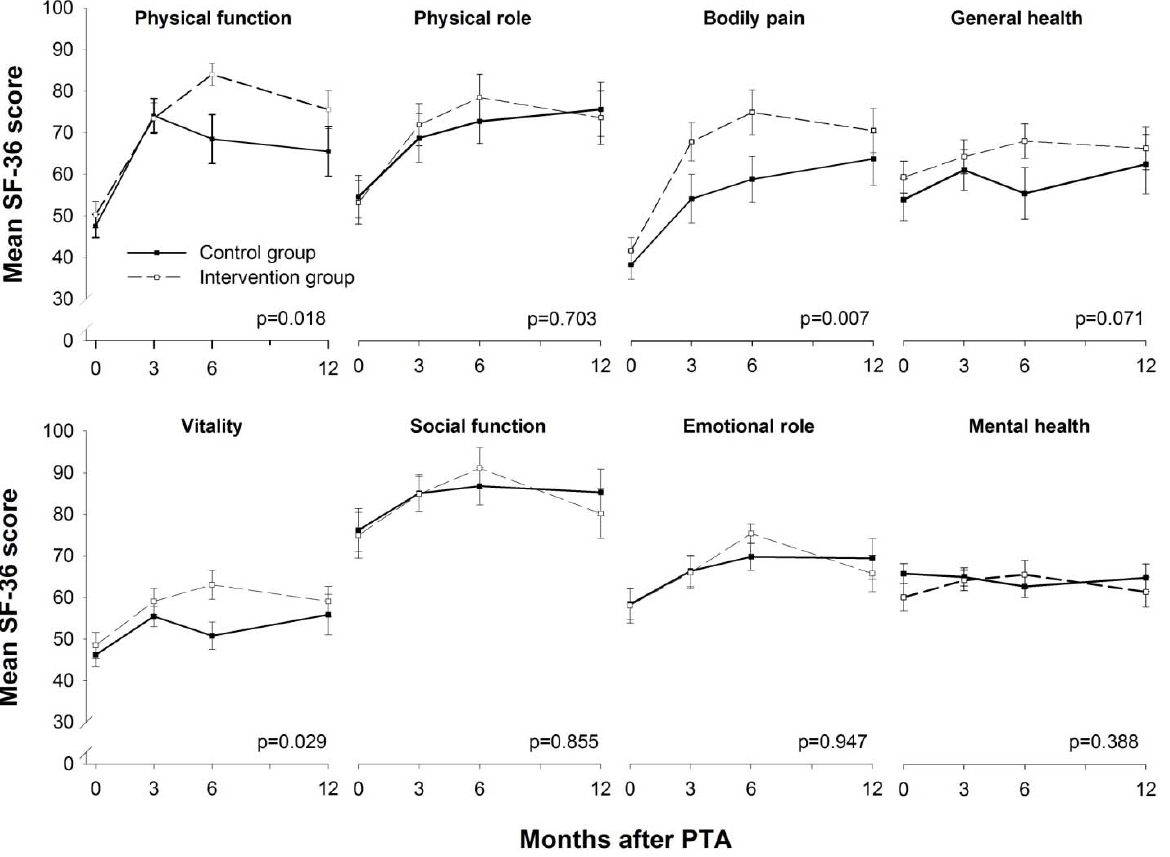
Figure 4. SF-36 domain scores. A score of 0 represents the worst possible health, and 100 represents the best possible health. SF-36 = Short Form-36 Health Survey. Values are mean, error bars indicate ±SEM.